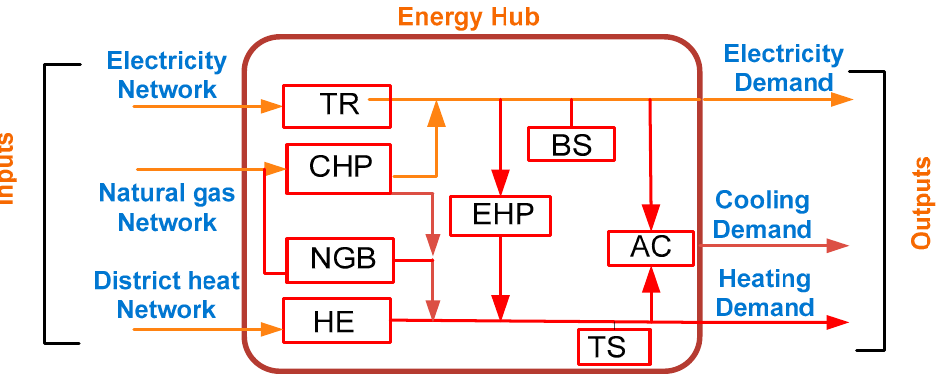
Figure 6. Illustration of an energy hub (EH) structure [54].